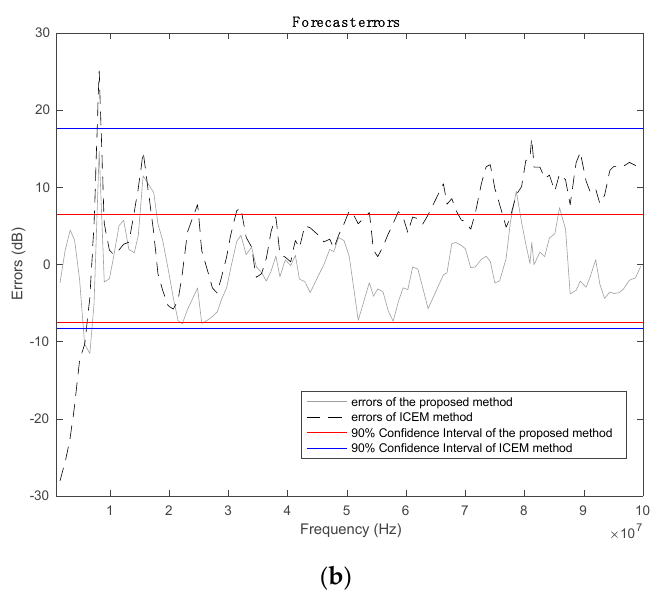
Figure 24. Comparison between the proposed method and ICEM method for Board 4. ( a ) Predicted results; ( b ) forecast errors.